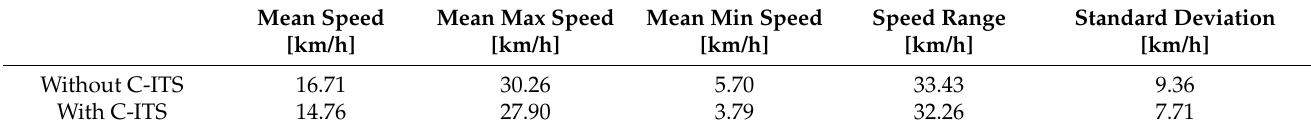
Table 3. Box plot of speed for all tested